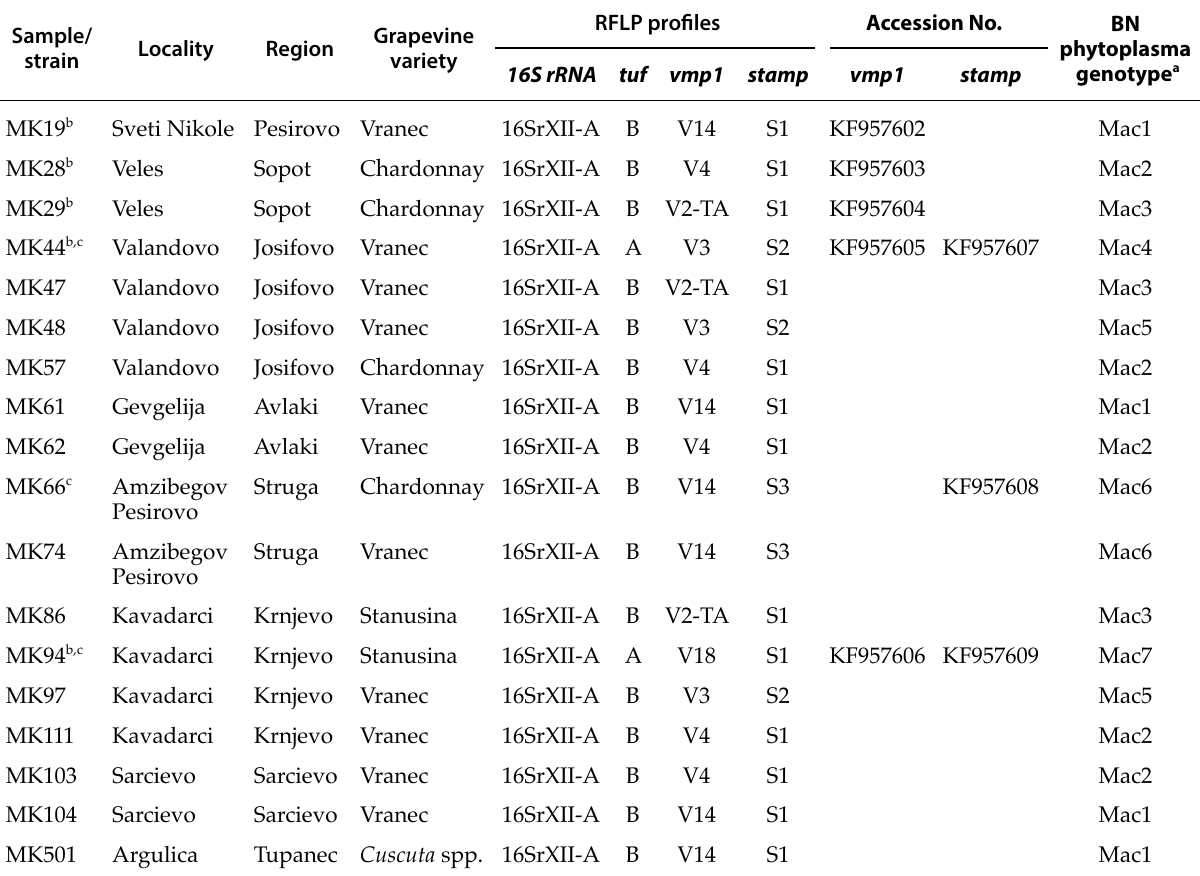
Table 1. Sample features and RFLP patterns of bois noir (BN) phytoplasma strains. Sample/